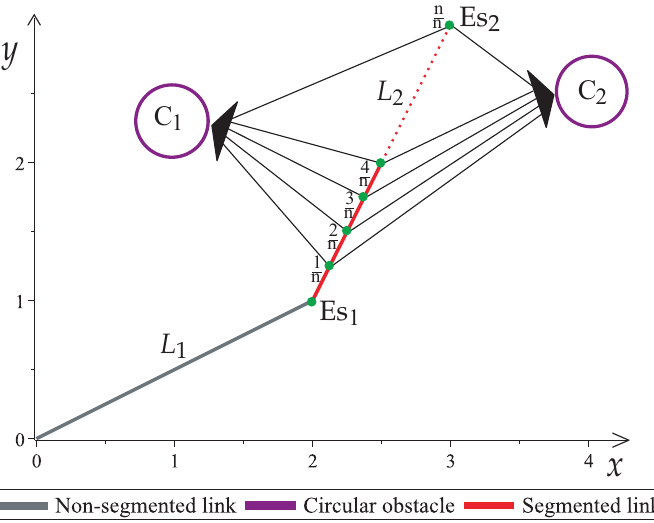
Figure 6. Singular projections of a two-link planar robot arm with two